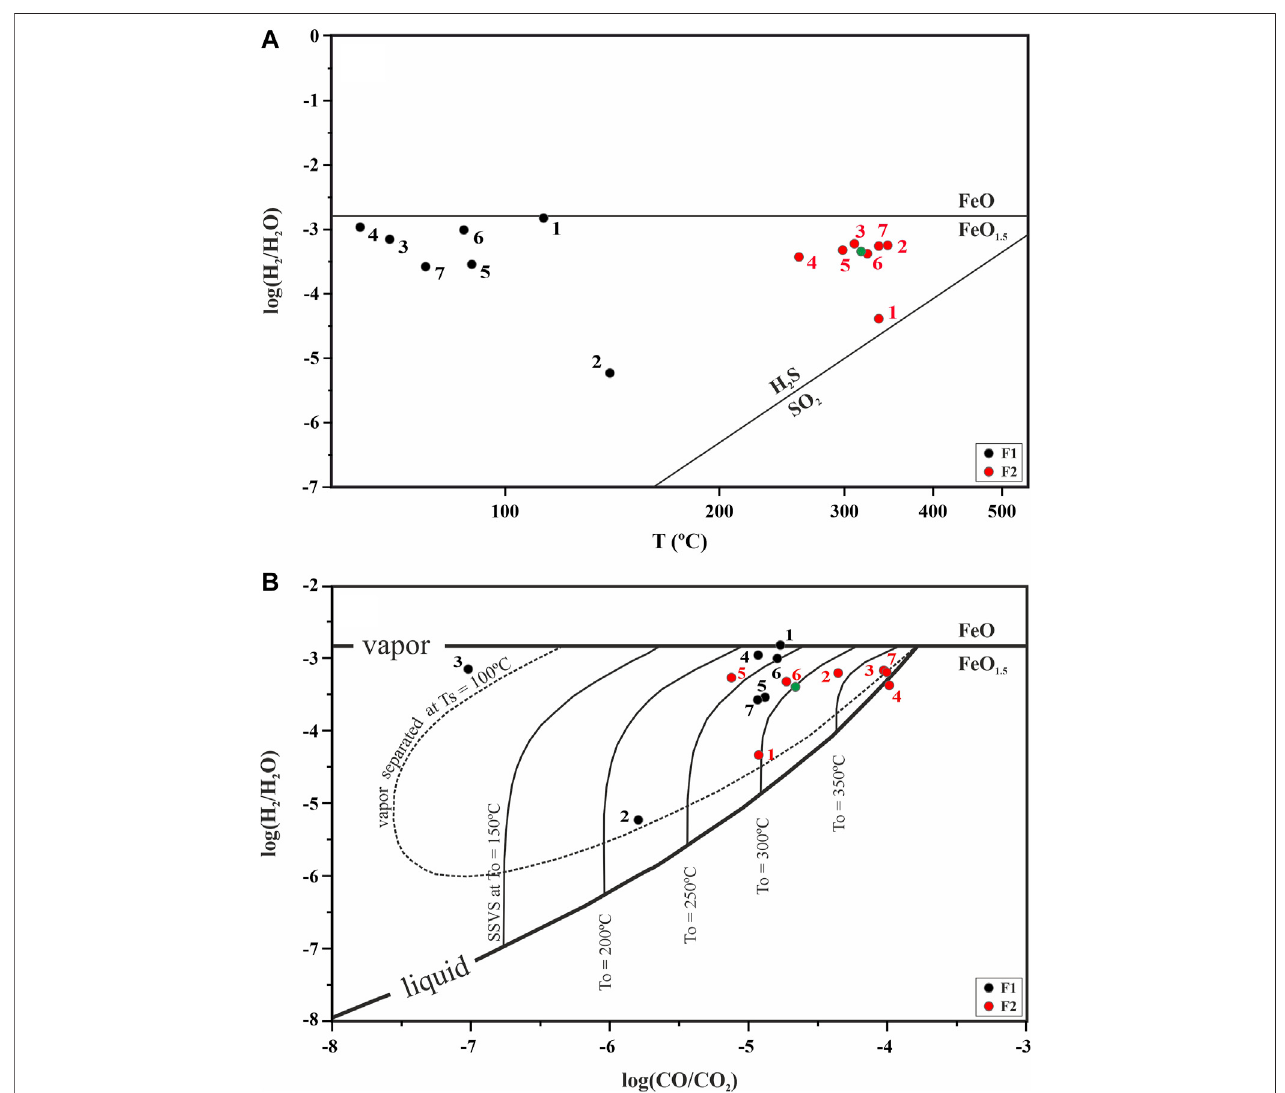
FIGURE2|(A) R H (cid:2) log(X H2 /X H2O )(where Xisthemole fraction)vs.outletfumaroletemperaturesfromPicodoFogovolcano.BufferlinesfromGiggenbach(1987). (B) log(X H2 /X H2O ) vs. log(X CO /X CO2 ) for different redox conditions (Giggenbach, 1987). Compositions of the vapor phase separated in a single-step (SSVS) at different temperatures from a liquid phase initially at T o (cid:2) 150, 200, 250, 300 and 350 ° C are also shown (thin solid lines), as well as the compositions resulting from single-step vapor separation at 100 ° C starting from any initial temperature (dashed lines). Acronyms as used by Chiodini and Marini (1998). Green dots represent data